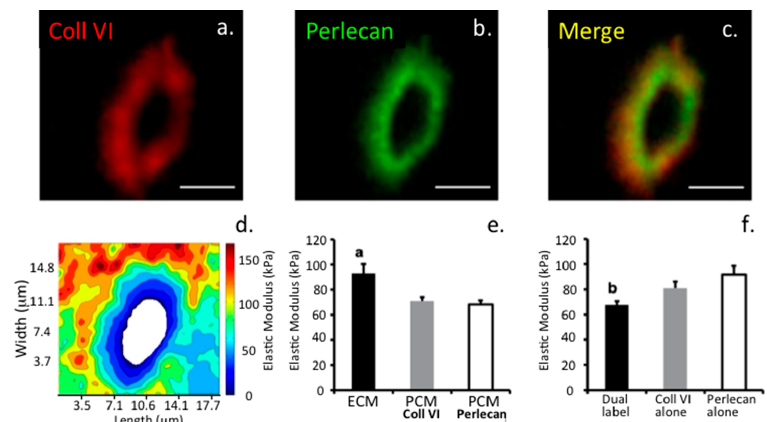
Figure 10. Correlative co-localization of perlecan and type VI collagen with the biomechanical properties of cartilage. ( a – c ) Dual immunofluorescence labeling of type VI collagen ( a , red), and perlecan ( b , green) within the pericellular matrix compartment of articular cartilage. The adjacent overlay image ( c ) shows their overlapping distributions. Scale bar = 5 µm. ( d ) Contour map of the calculated elastic moduli for the pericellular matrix region shown in ( a – c ), as determined by AFM scanning. ( e ) Elastic moduli of cartilage extracellular matrix (ECM) and pericellular matrix (PCM) as defined by the presence of type VI collagen or perlecan. There is no difference between biochemical definitions of the PCM ( p = 0.70). ECM elastic moduli were significantly greater than PCM moduli (a: p < 0.005 as compared to either PCM definition). ( f ) Regions that were dual-labeled for type VI collagen and perlecan exhibited lower elastic moduli than regions positive for type VI collagen or perlecan alone (b: p < 0.05 as compared to type VI collagen and perlecan alone regions). Data presented as Mean + SEM. Figure reproduced from [43] with permission.